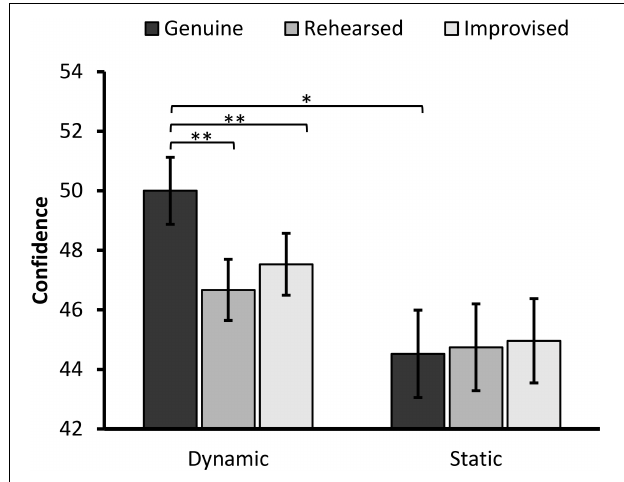
FIGURE 5 | Confidence scores in the dynamic and static format split by expression type (error bars ± 1 SE). The asterisks represent a significant difference at ∗ p < 0.01 and ∗∗ p ≤